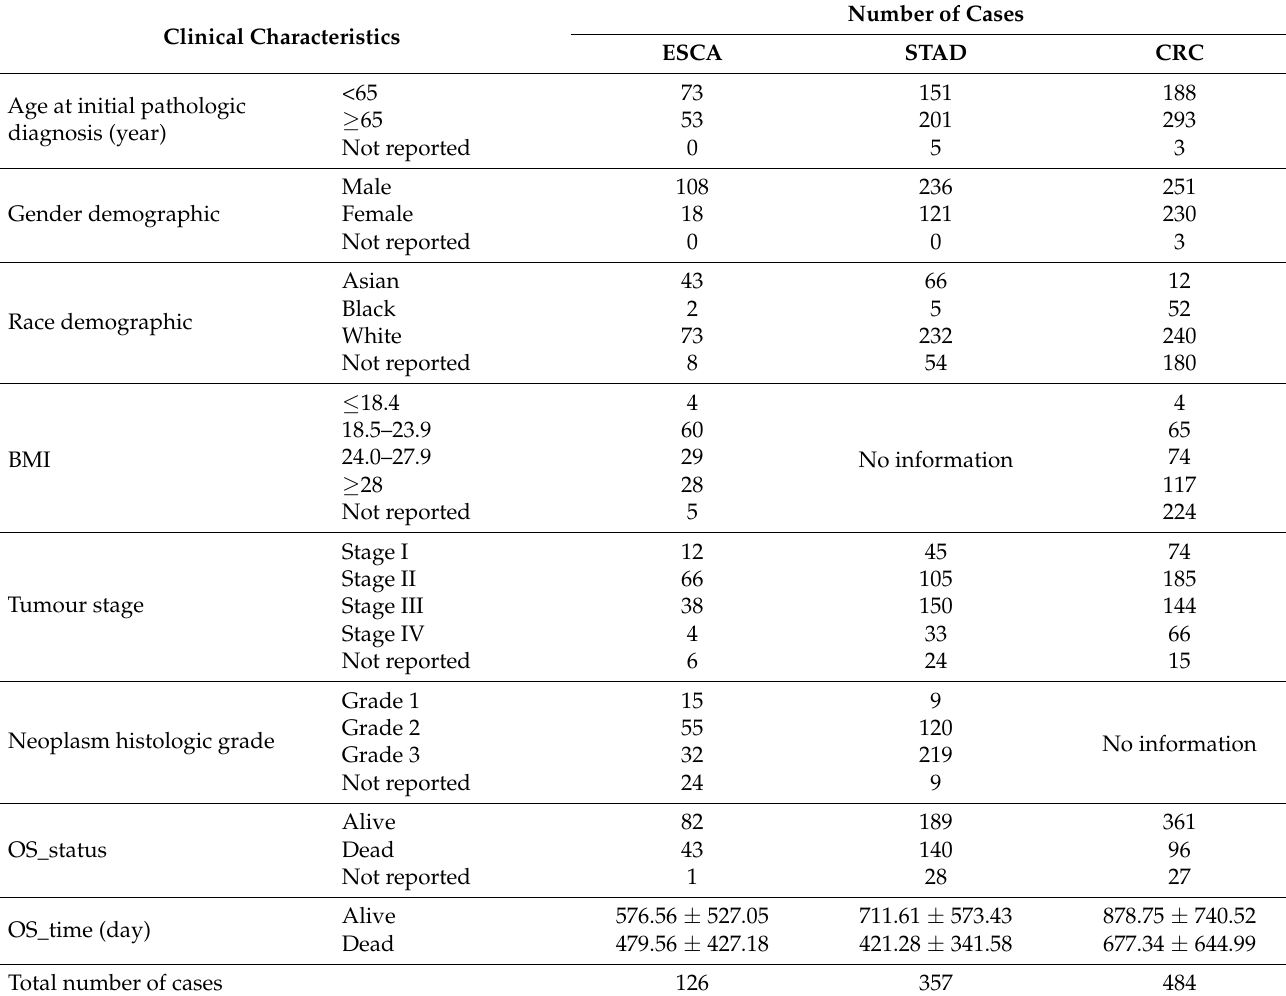
Table 1. Clinical characteristics of ESCA, STAD, and CRC samples in this